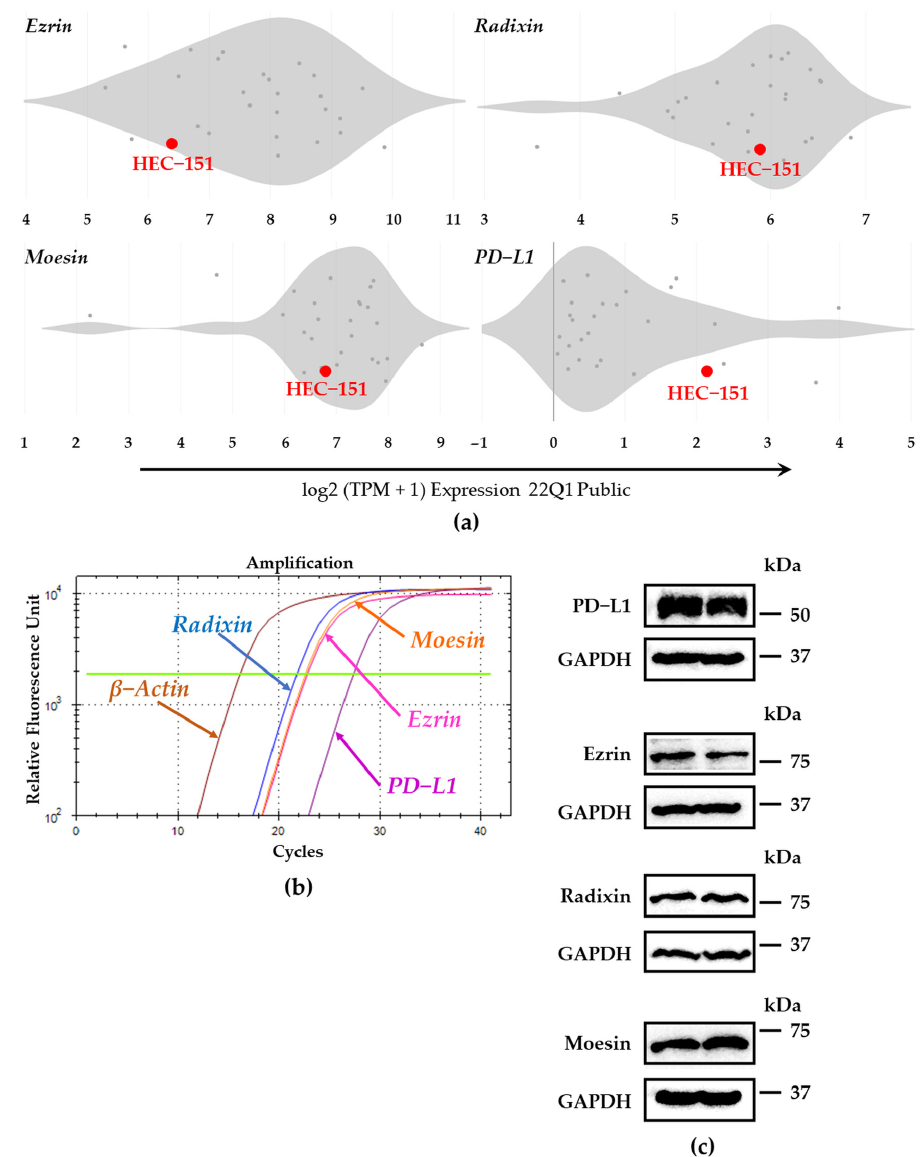
Figure 1. Expression profiles of ezrin, radixin, moesin (ERM), and programmed death ligand-1 (PD -L1) at mRNA and protein levels in HEC-151 cells. ( a ) Violin plots showing the median gene expression (log2 (TPM + 1)) of ERM and PD-L1 in numerous human endometrial cancer cells obtained from the Cancer Dependency Map (DepMap) portal data explorer, DepMap 22Q1 Public. ( b ) Amplification curves for each target gene in HEC-151 cells, as measured by real-time reverse transcription–polymerase chain reaction. ( c ) Immunoblot images of each protein in HEC-151 cells. Upper panels; ezrin, radixin, moesin, and PD-L1, lower panels; corresponding glyceraldehyde-3- phosphate dehydrogenase (GAPDH) shown in duplicate. Molecular weights;